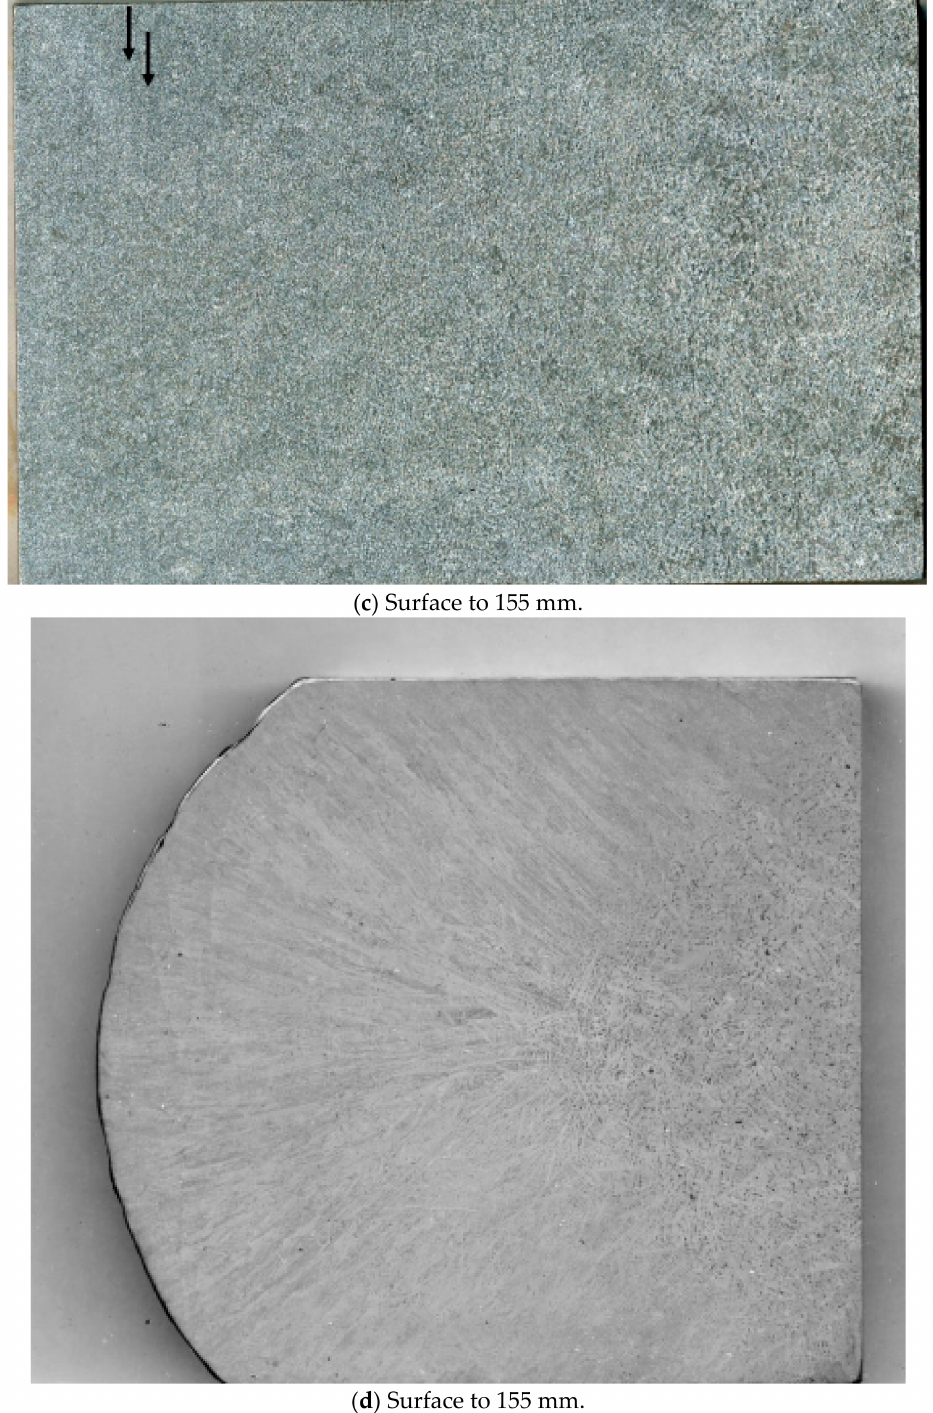
Figure 4. Examples of the macrostructures in the electrode and the ingots. ( a ) Electro-slag remelted 400 × 400 mm 2 ingot (ESR-400), from surface to position T/4 (in between corner and center). ( b ) Pressure electro-slag remelted 500 mm diameter ingot (PESR-500) with position T/6 (in between corner and position T/4) and position T/4 marked. The arrows point at the etching concentric bands. ( c ) Pressure electro-slag remelted 1050 mm diameter ingot (PESR-1050) from surface to 155 mm. The arrows point at the etching concentric bands. ( d ) Electrode 300 × 300 mm 2 (CE-300) from surface to 155